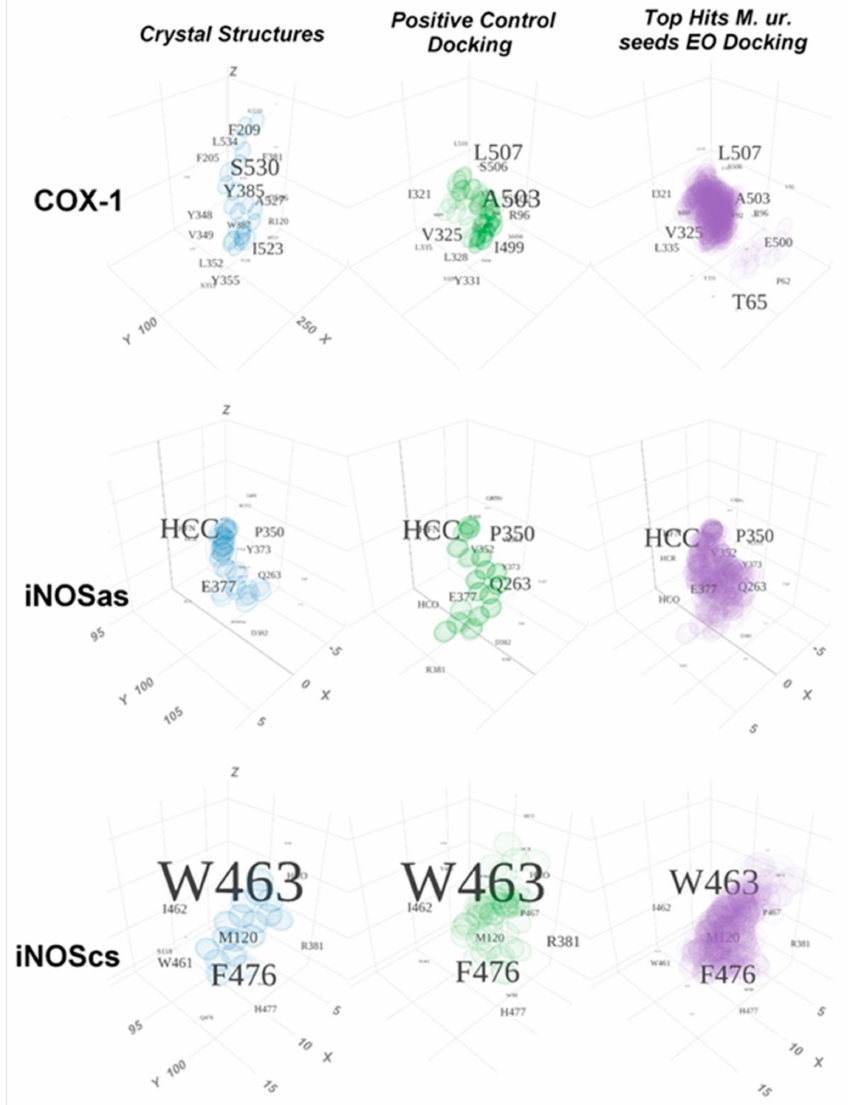
Figure 8. Tridimensional graphic representation of the major contacts at the active site for positive controls and top compounds from essential oils from M. urundeuva seeds. The tridimensional repre- sentation (at the x, y, z axes) of each respective active site is arbitrarily centralized at the geometrical center of the set of atoms involved in contacts around all the analysis. The grid spacement at the three-dimensional space in each graphic is always of 5 Å at each dimnension. The density of the spheres on the image depicts how many superposed atoms there are at that region between different docks with the same ligand (the three first poses from the docking procedure were considered) and between different compounds. The font size depicting the residue identity and number increases according to the average intensity of the contacts involving it (i.e., the average contact area superpo- sition between the ligands and the residue). The subdivision of the large Heme group was carried out as mentioned in the Materials and Methods section. From top to bottom it can be noticed the contacts for the COX-1, iNOSa.s. and iNOSc.s. pockets. From the left to the right the respective contact intensities for the crystallographic controls (the arachidonic acid contacts at the PDB-ID:1DIY for COX-1, the L-Arginine-iNOS contacts at the PDB-ID:3NOS plus the isothiourea-iNOS contacts at the PDB-ID:4NOS for iNOSa.s., the tetrahydroneopterin-iNOS contacts at the PDB-ID:4NOS for iNOSc.s.); for the docked three first poses for the most positive controls (arachidonic acid for COX-1, bis-isothiourea for iNOSa.s. and tetrahydropterin for iNOSc.s.); as well the three first poses of the top hits for each site are depicted. M. ur. = Myracrondruon urundeuva . EO = Essential